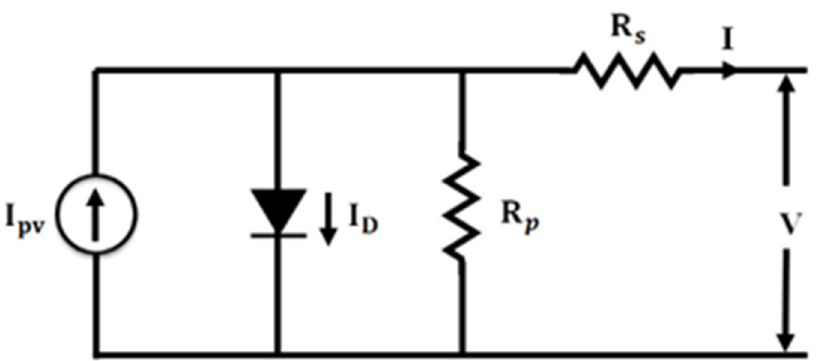
Figure 2. The equivalent circuit of solar photovoltaic cell.